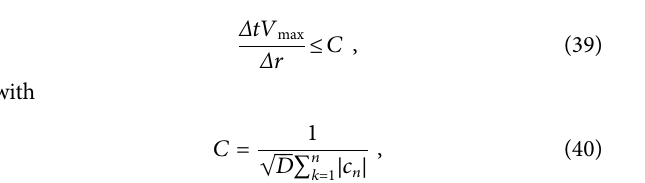
Frontiers in Earth Science |